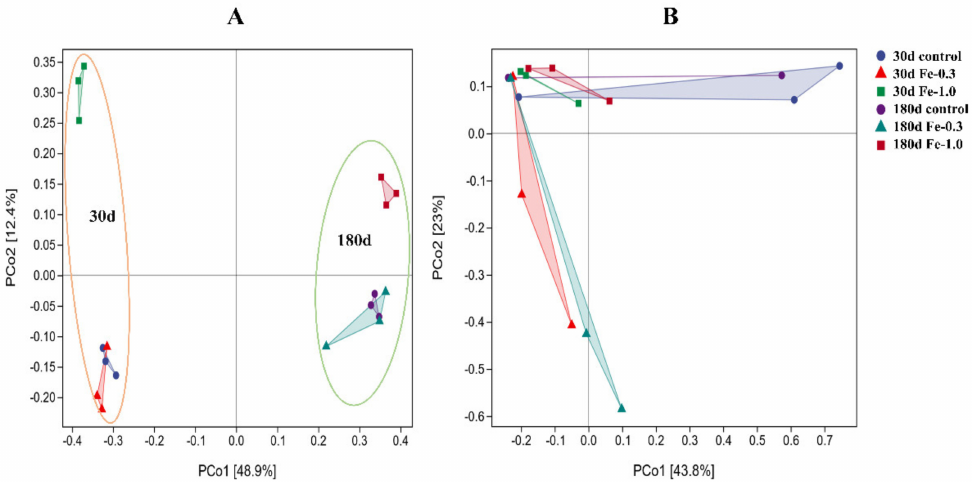
Figure 3. Principal coordinates analysis (PCoA) with Bray–Curtis distance for bacterial communities ( A ) and fungal communities ( B ) between Fe-1.0 and control.